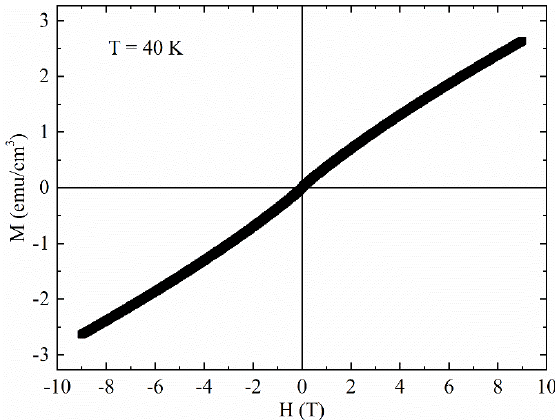
Figure 3. Magnetic hysteresis loop at T = 40 K.